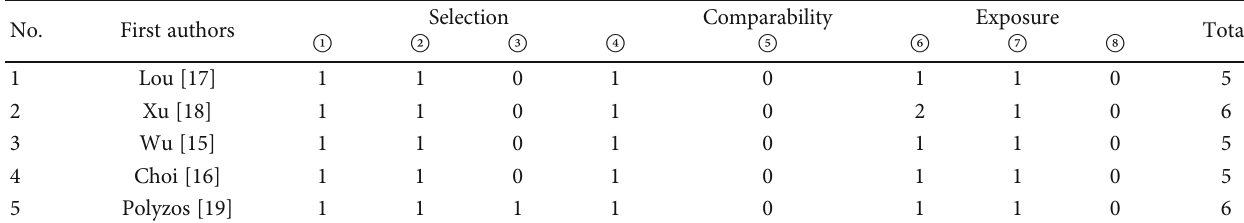
Table 2: Scores of the Newcastle-Ottawa Scale.